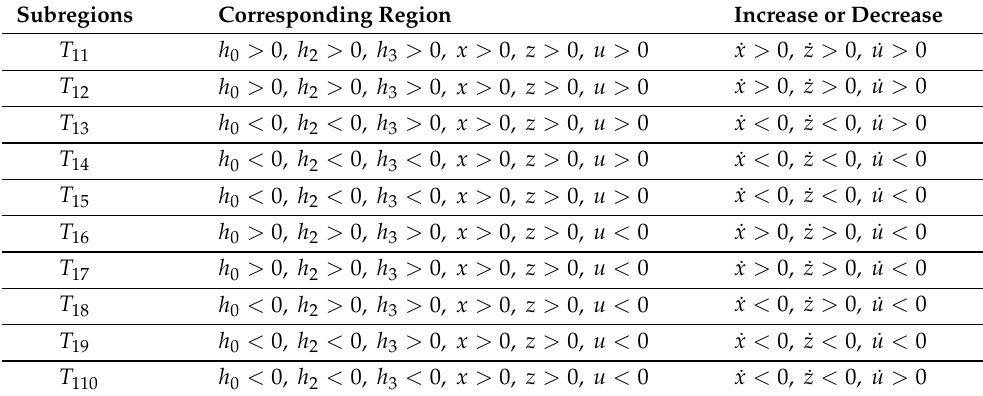
Table 13. Dynamical behavior in the ten subregions.